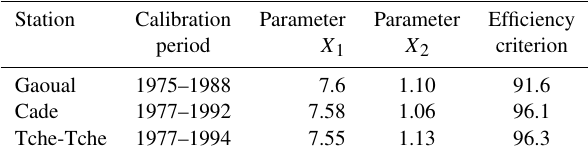
Table 5. Calibration and validation of